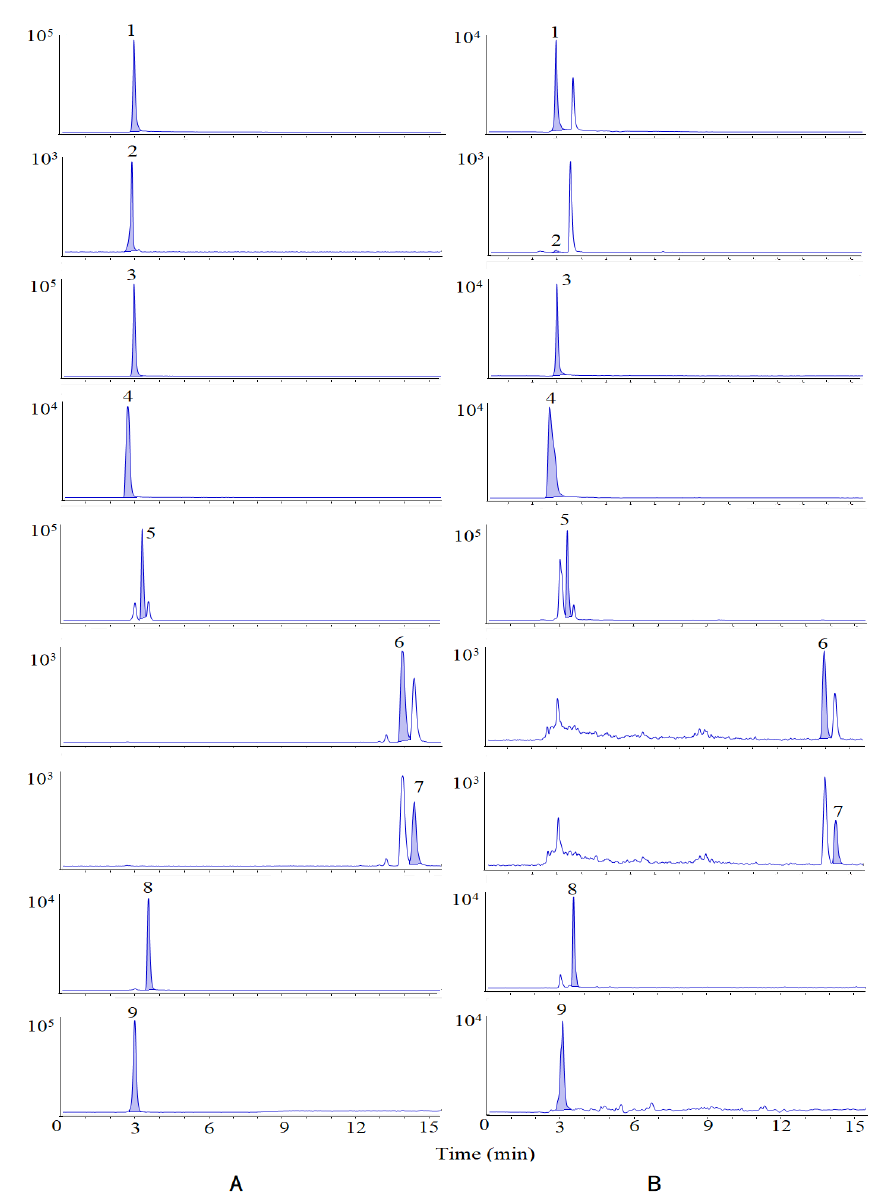
Figure 4. MRM of standards ( A ) and samples ( B ). Peaks are as follows: (1) isovanillin, (2) isovanillic (3)scopoletin, (4)chlorogenicacid, (5)periplogenin, (6)oleanolicacid, (7)ursolicacid, (8)periplocymarin, acid, (3) scopoletin, (4) chlorogenic acid, (5) periplogenin, (6) oleanolic acid, (7) ursolic acid, (8) and (9) periplocymarin, and (9) periplocin.